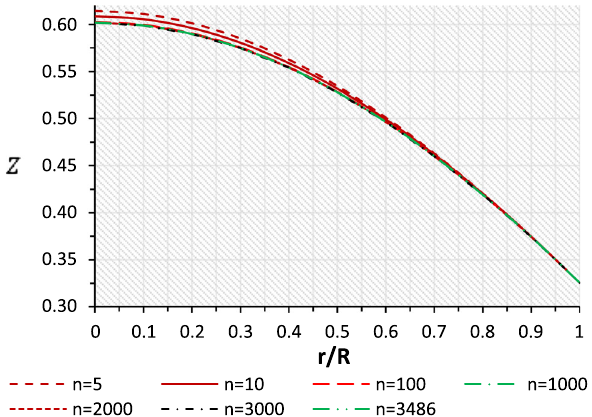
Fig. 7 Behaviour of surface redshift ( Z s ) vs. radial coordinate r / R with different values of n for LMC X − 4